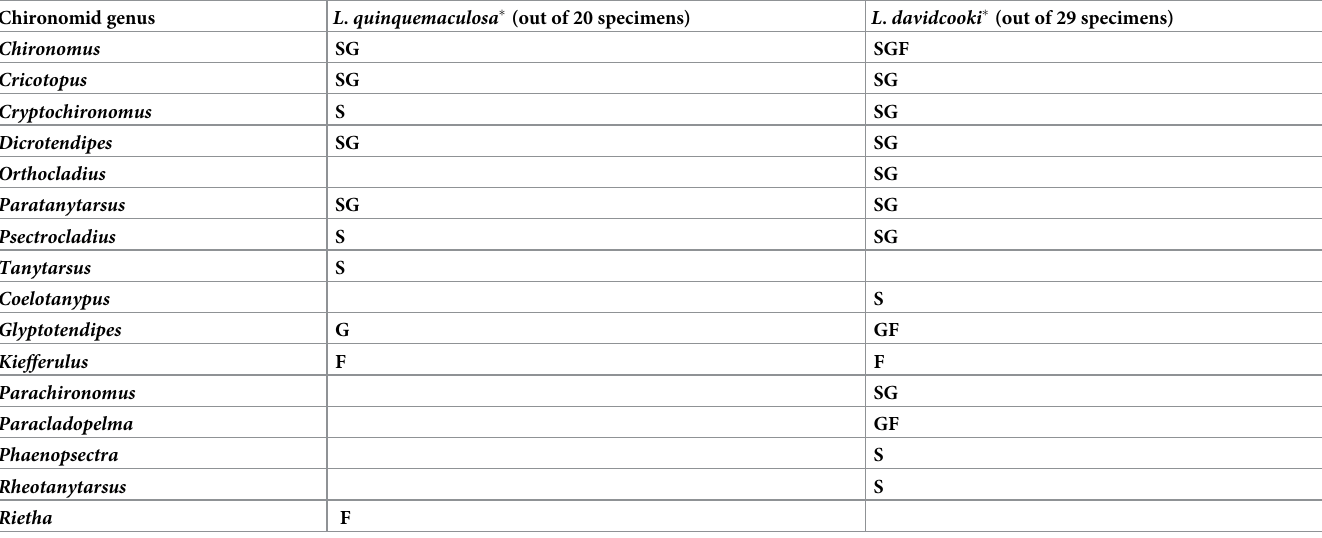
� Shown only for sequence clusters (OTUs) accounting for > 0.1% of non-mite DNA sequences. Key to abbreviations: S, > 96.5% identity; G, 90% to 96.5% identity; F, 80 to 90% identity to “best hit” GenBank reference sequences.